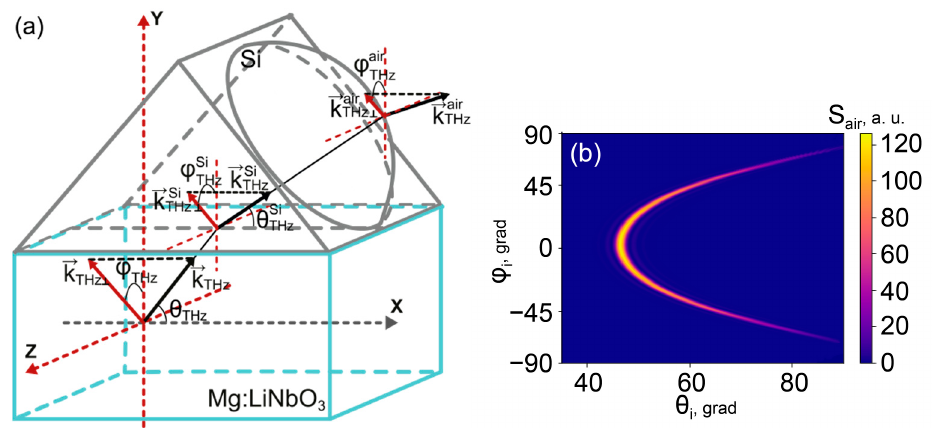
Figure 3. ( a ) Directions of THz wave components in the crystal, inside and outside the Si-prism-lens coupler; ( b ) angular distribution of the power density at 1 THz outside the flat Si-prism (lensless) coupler.